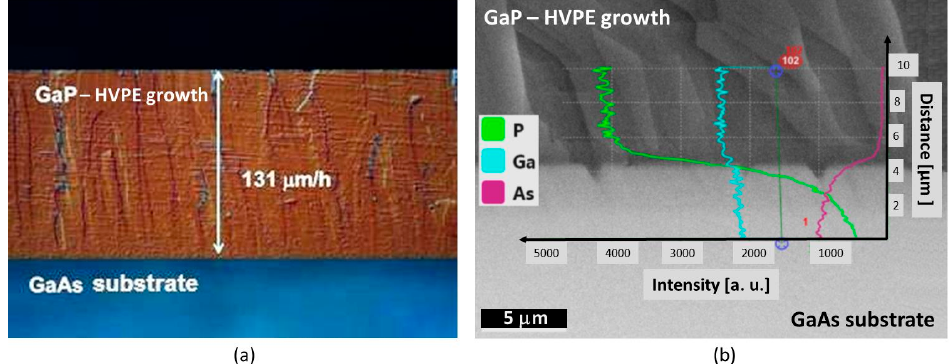
Figure 15. ( a ) Cross section of HVPE heteroepitaxy of GaP on GaAs substrates; ( b ) Elemental profile analysis across the interface between the GaAs substrate and the grown GaP layer [59]. (Reproduced from [59] with the permission of OSA).